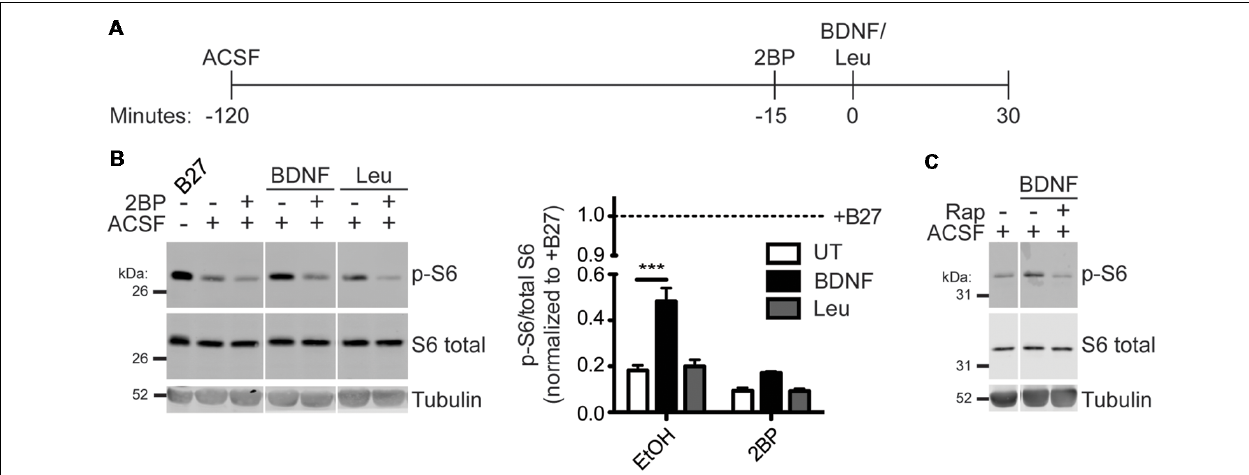
FIGURE 3 | Brain-derived neurotrophic factor (BDNF) activation of mTORC1 in hippocampal neurons is palmitoylation-dependent. (A) Scheme of the BDNF stimulation paradigm. DIV14–16 primary rat hippocampal neurons were placed in artificial cerebrospinal fluid (ACSF) for 2 h before stimulation with 100 ng/mL BDNF or 5 mM Leu. Fifteen minutes prior to stimulation, cells were treated with ethanol (EtOH) or 50 µ M 2BP to inhibit palmitoylation. Neurons were stimulated for 30 min with BDNF or Leu. (B) Lysates were blotted to detect p-S6 (top), S6 total (middle), and tubulin (bottom) levels. Right panel histogram shows quantified data from multiple experiments, normalized to the regular growth media with B27 (+B27) condition [two-way ANOVA: 2BP p < 0.0001 ( F ( 2 ) = 28.41), treatment p < 0.0001 ( F ( 1 ) = 59.31), interaction p = 0.0017 ( F ( 2 ) = 9.52); N = 3–5; Bonferroni post hoc test ∗∗∗ p < 0.001]. Panels are composites of the same Western blot image. (C) Neurons were stimulated as in B with BDNF, but 15 min prior to stimulation cells were treated with EtOH or 100 nM rapamycin (Rap) to inhibit